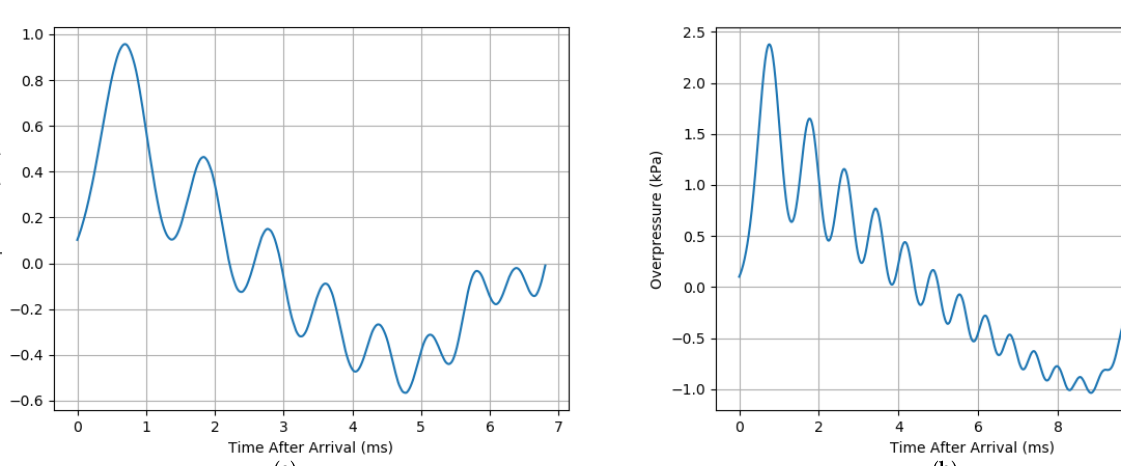
Figure 3. Pressure time histories from four simulations of hemispherical TNT detonation of different